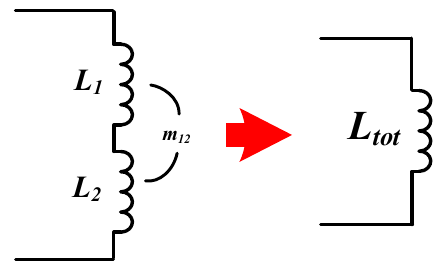
Figure 8. Geometry of single rectangular coil.